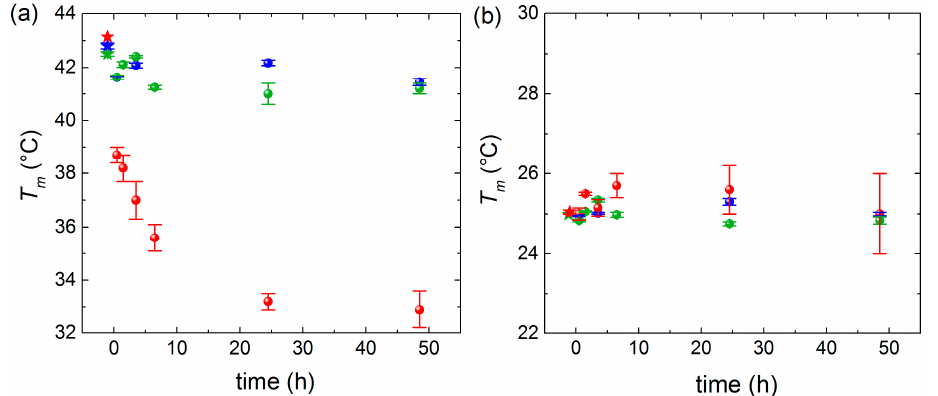
Figure 4. Dependence of the incubation time on T m values extracted from ( a ) high- T peaks and ( b) low- T peaks (blue points for T = 16 °C, green points for 32 °C, red points for 50 °C). Stars represent T m of pure DPPC vesicle ( a ) and pure DMPC vesicles ( b ), which are used as reference.